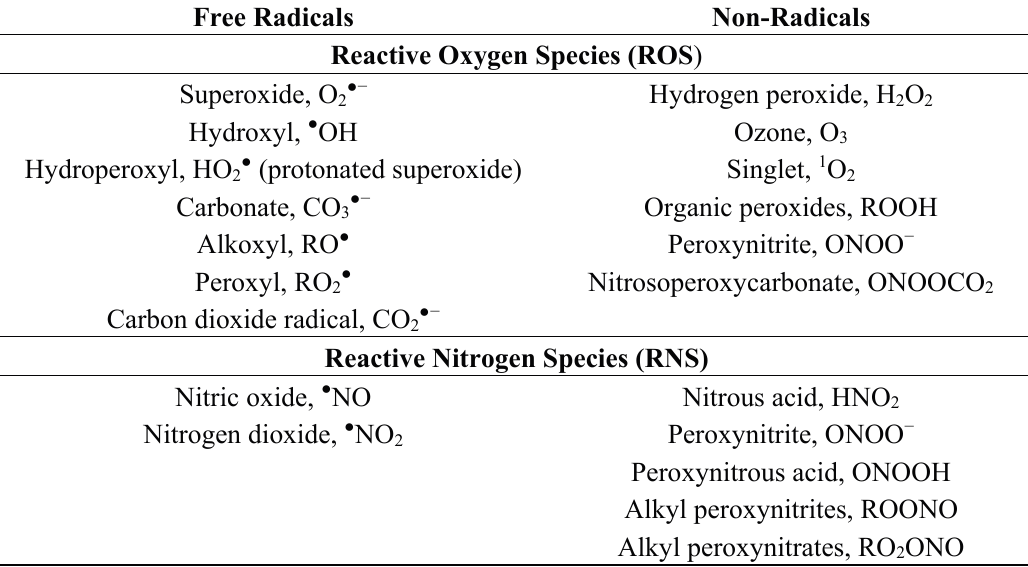
Table 2. A list of various reactive